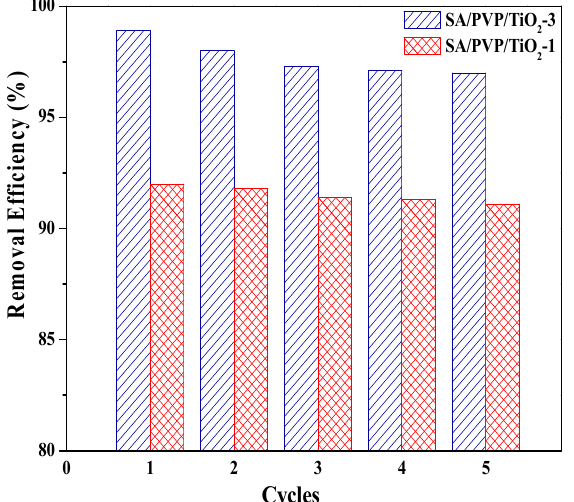
Figure 8. Reusability of SA/PVP/TiO 2 nanocomposites for the removal of MB during 5 consecutive cycles (at 120 min; pH 7; 50 mg L − 1 initial MB concentration).